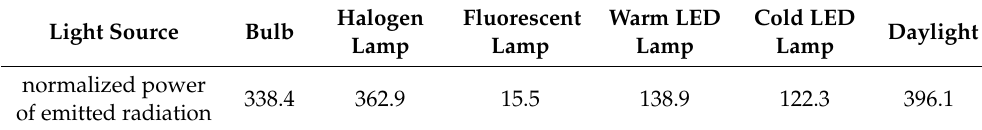
Halogen Fluorescent Warm LED Cold LED Daylight Lamp Lamp Lamp Lamp